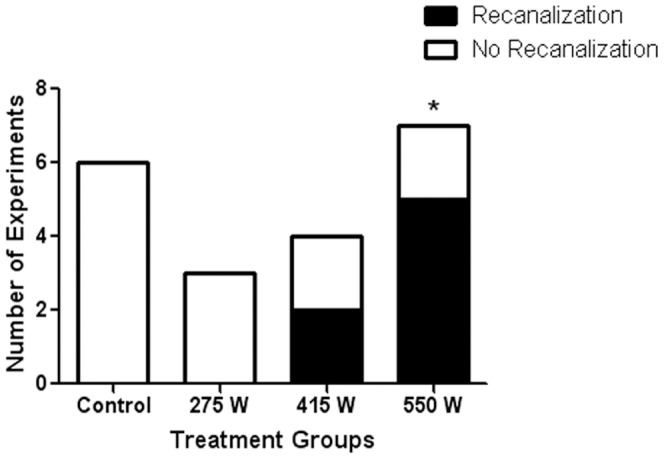
HIFU (550 W) significantly enhances reperfusion.Reperfusion was expressed as a proportion of the total animals tested at each power and the values were compared using Fisher's exact test. HIFU treatment with increasing powers was statistically significant (*p<0.05).